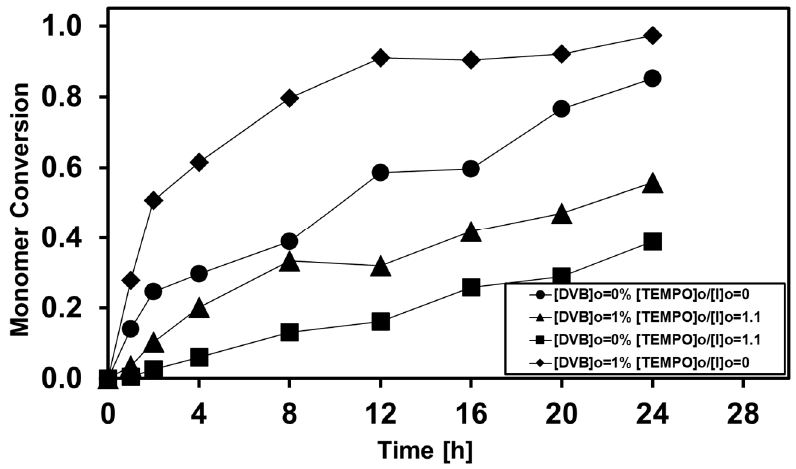
Figure 2. Conversion versus time profiles for the NMC of STY/DVB at [DVB] = 1 wt.% and [TEMPO]/[BPO] = 1.1 (triangles) against reference cases of FRP of STY (Case 1, circles), NMP of STY (Case 2, squares), and FRC of STY/DVB (Case 3, diamonds).